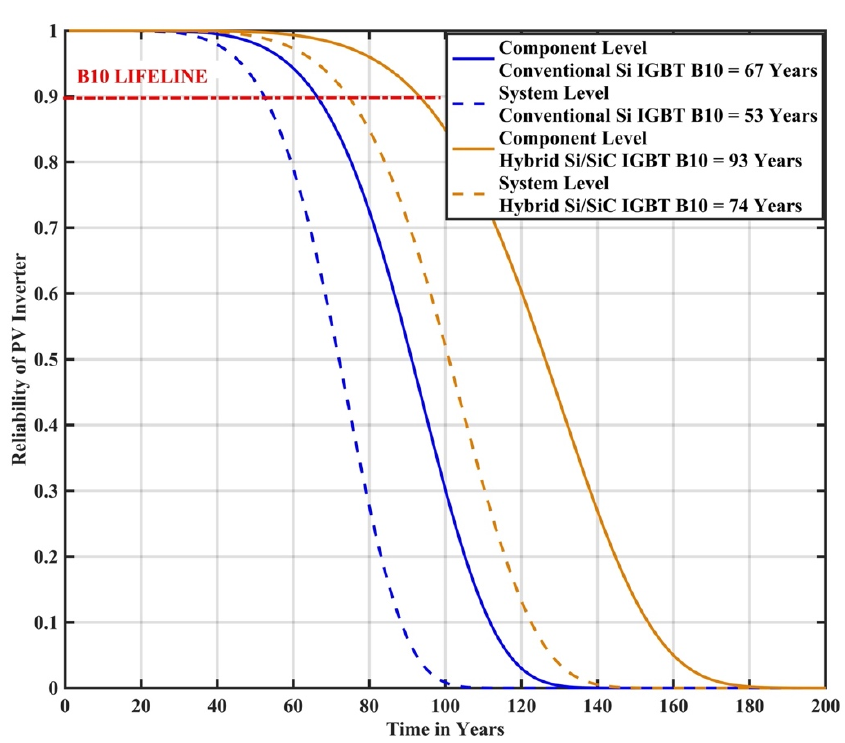
Figure 15. B 10 lifetime in Denmark.